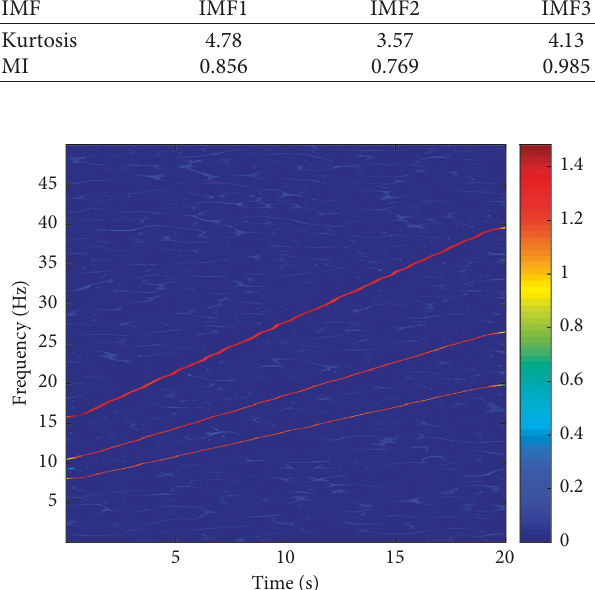
Figure 5: Time-frequency representation of LFM signal based on